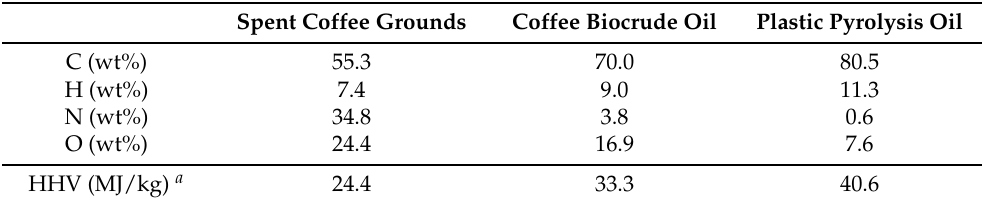
Table 2. Elemental compositions of spent coffee grounds, coffee biocrude oil, and plastic pyrolysis oil. Spent Coffee Grounds